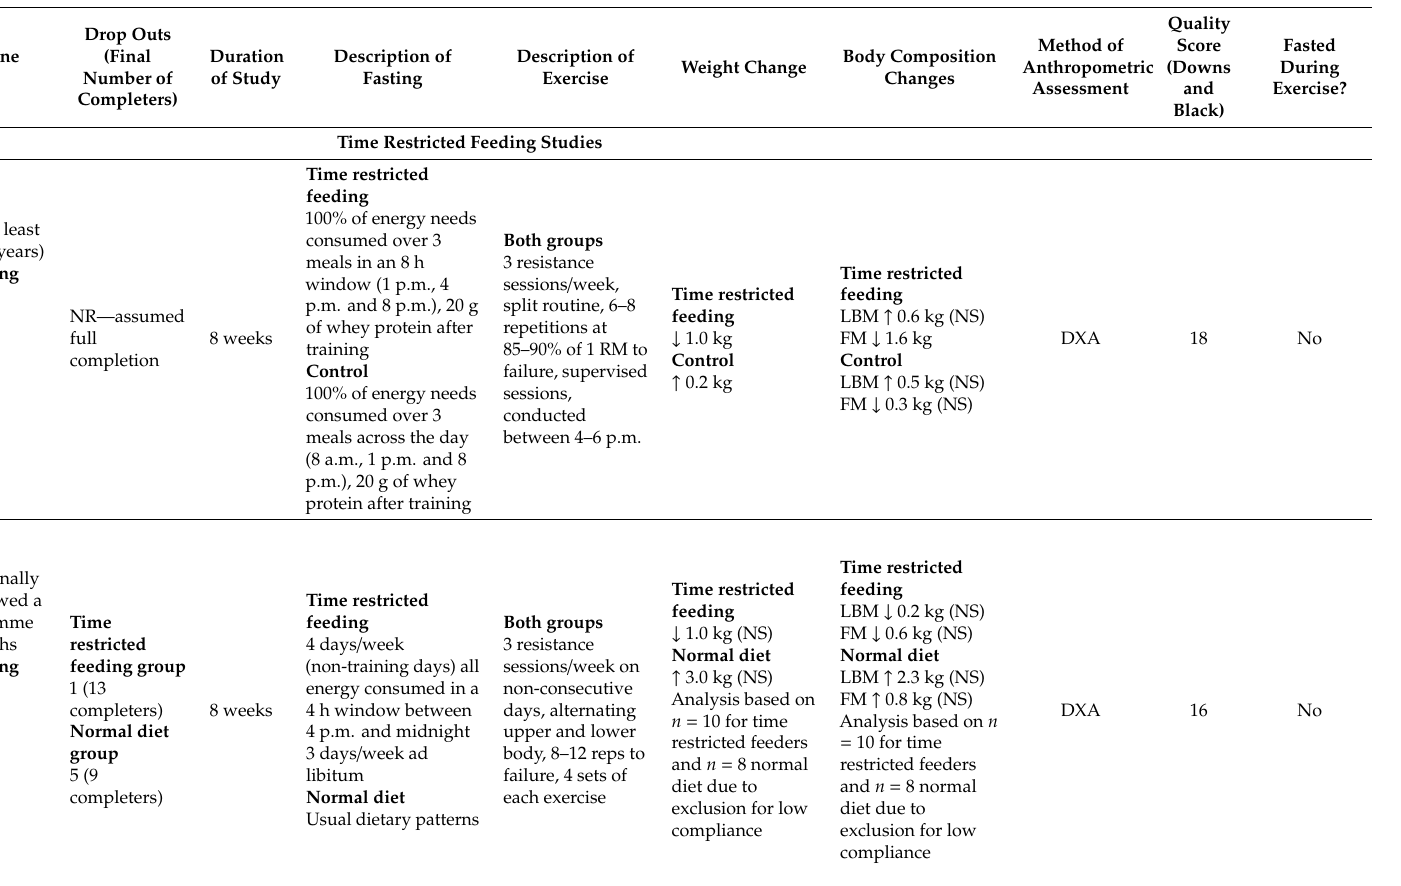
Table 1. Intermittent fasting combined with exercise and e ff ect on body